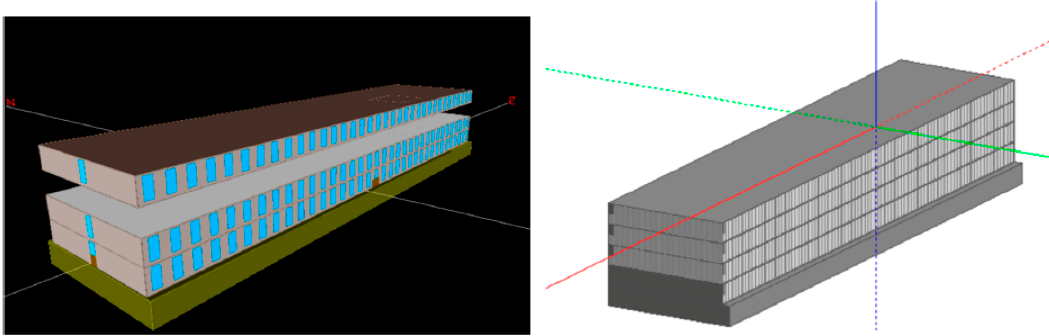
Figure1. Figure 1. Geometric Visualization of the monitored building from eQUEST and DesignBuilder interfaces.